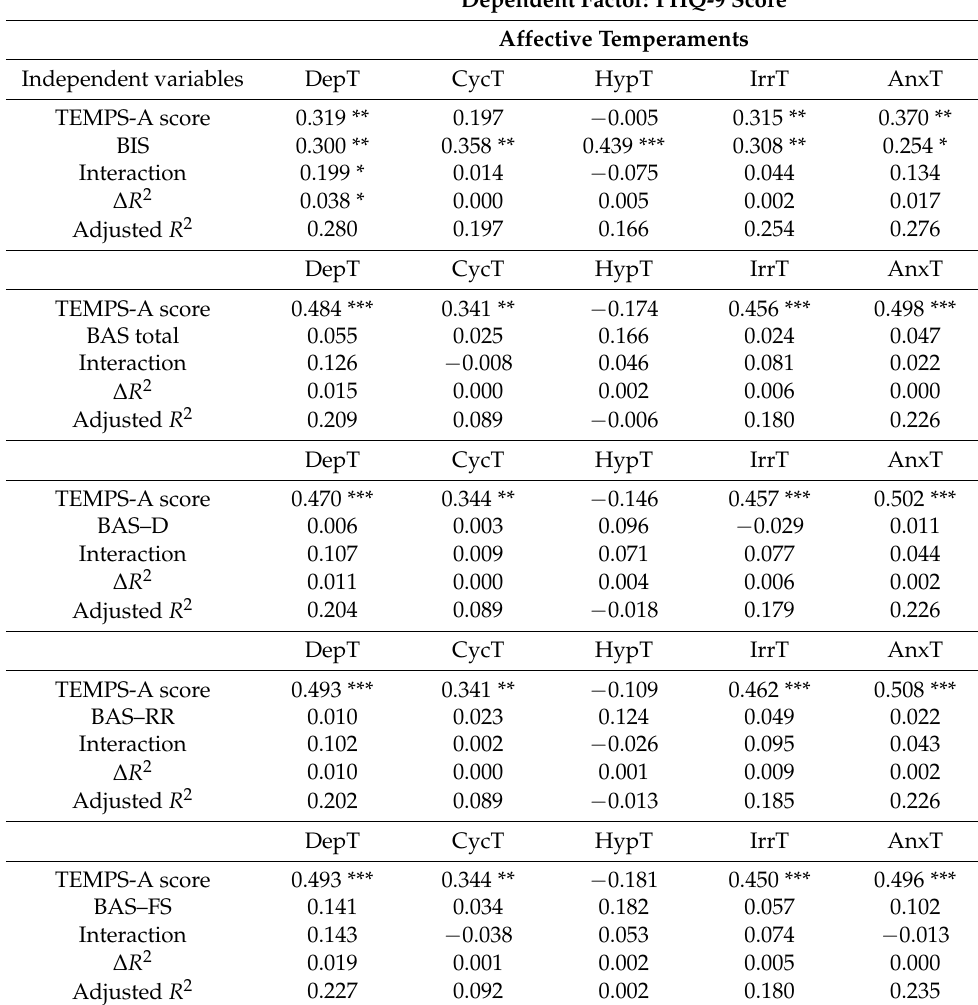
Table 3. Moderation analysis ( N =